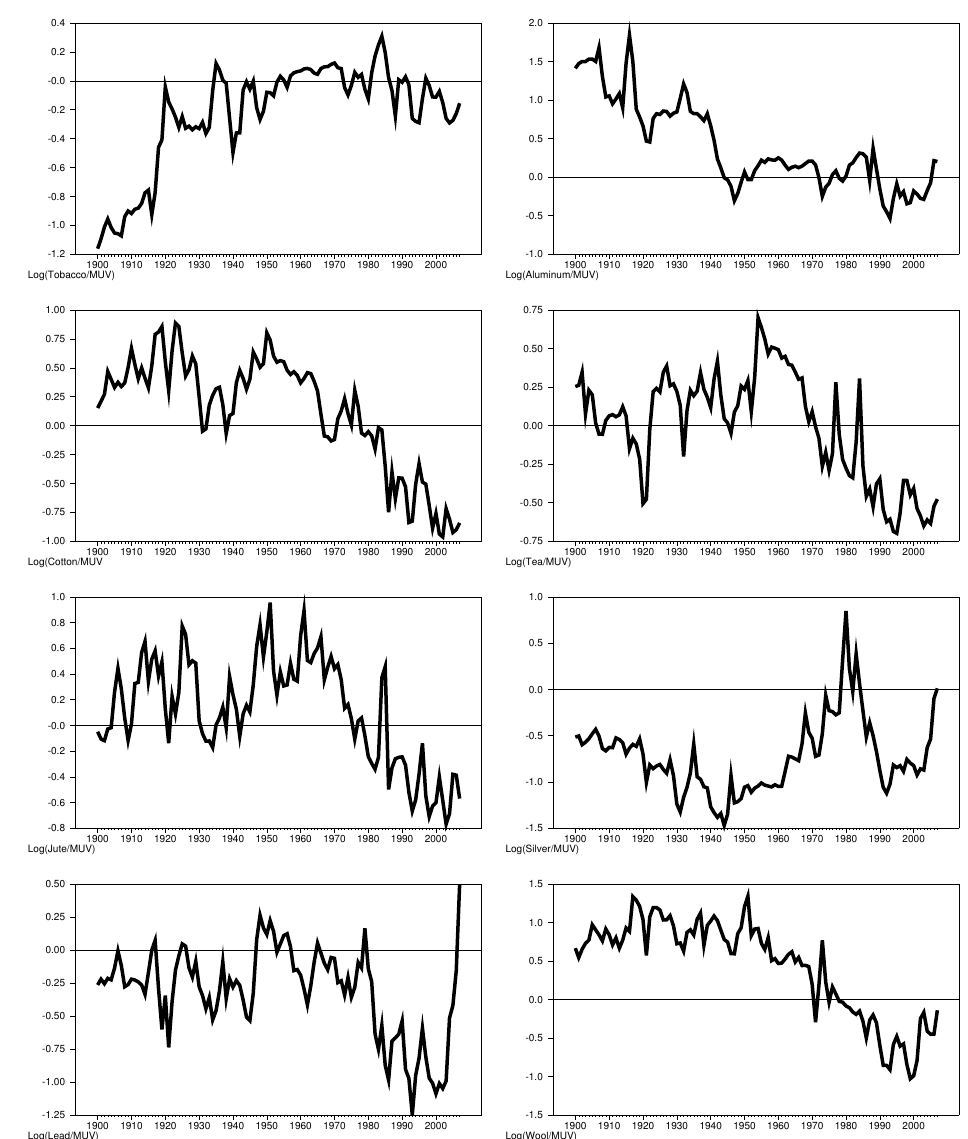
(cid:16) (cid:17) i t for every commodity price i in Group A in Table MUV t